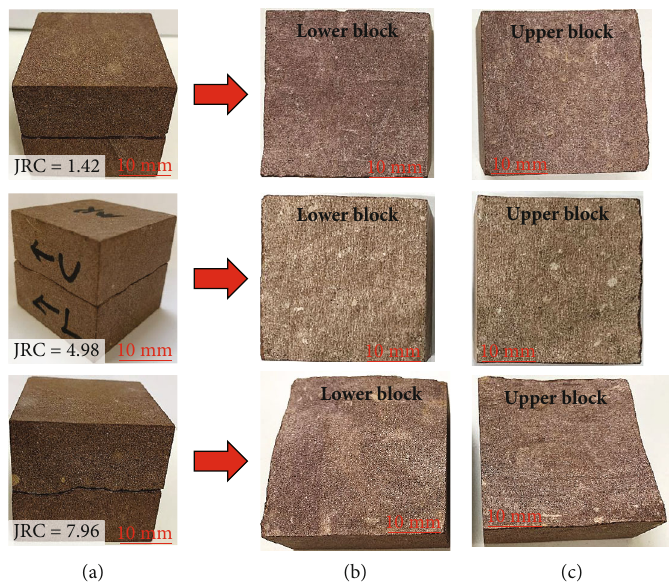
Figure 3: Engraved rock joint specimens of sandstone with natural joint surfaces: column (a) pairs of joint specimens; column (b) lower blocks of joint specimens; column (c) upper blocks of joint